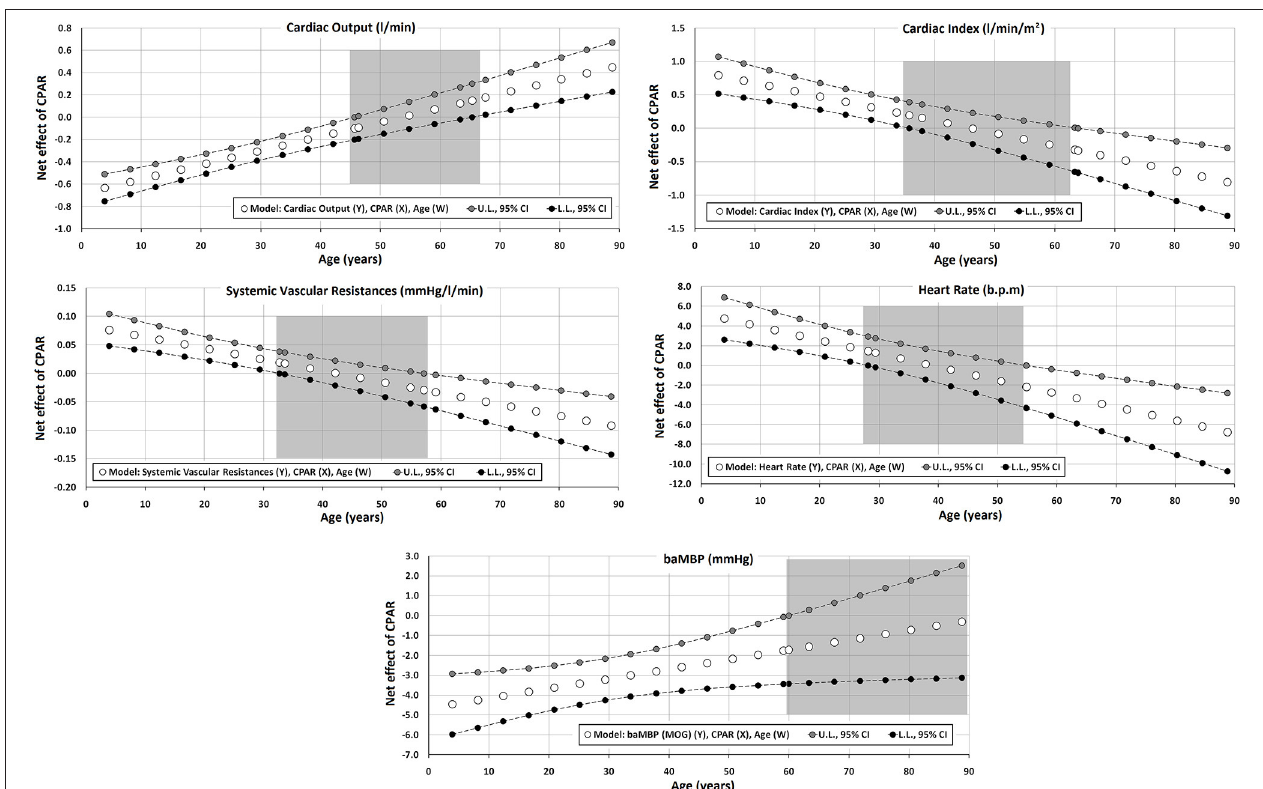
FIGURE 2 | Effect of compliance with physical activity recommendation (CPAR) condition on global hemodynamic indexes: effects at different ages throughout life. The gray area shows regions that do not reach statistical significance. Complete quantitative information related to interactions and/or Johnson-Neyman regions is detailed in Supplementary Tables 2 – 95 . In each panel, the “net or absolute conditional effect” (and its 95% confidence interval) of reaching CPARs = 1, quantified in the units of the cardiovascular variable, was plotted as a function of age. If the confidence interval crosses the value “0,” the effect of CPARs on the cardiovascular variable becomes statistically non-significant ( p ≥